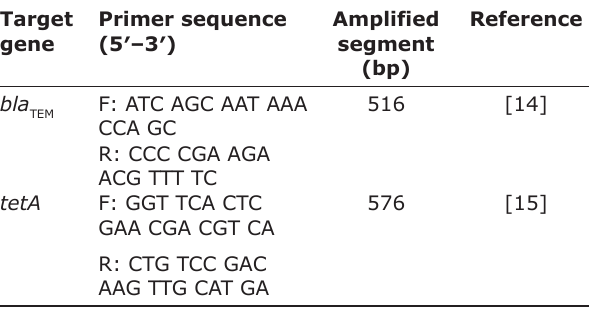
Table-2: Target genes, primer sequences, amplicon sizes, and cycling